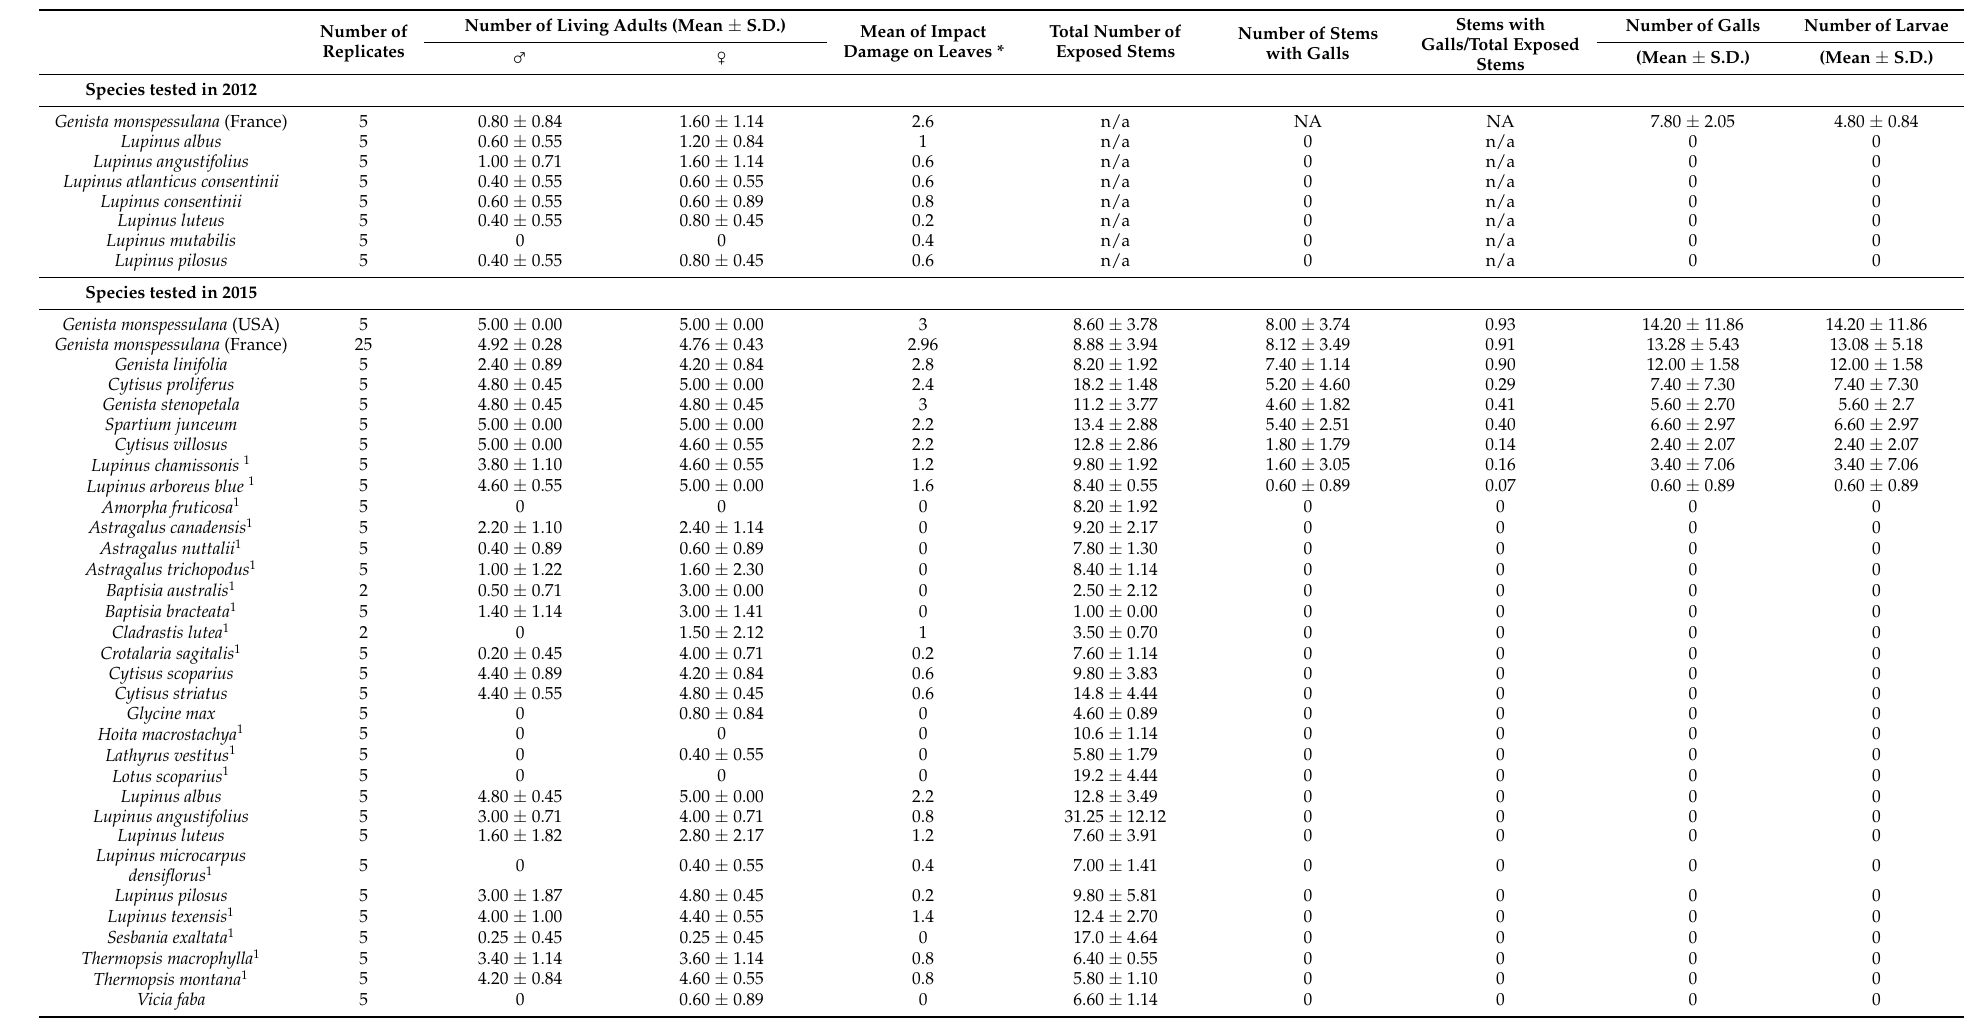
Stems with Number of Galls Number of Larvae Total Number of Number of Stems Galls/Total Exposed Damage on Leaves * Exposed Stems with Galls (Mean ± S.D.) (Mean ± Stems